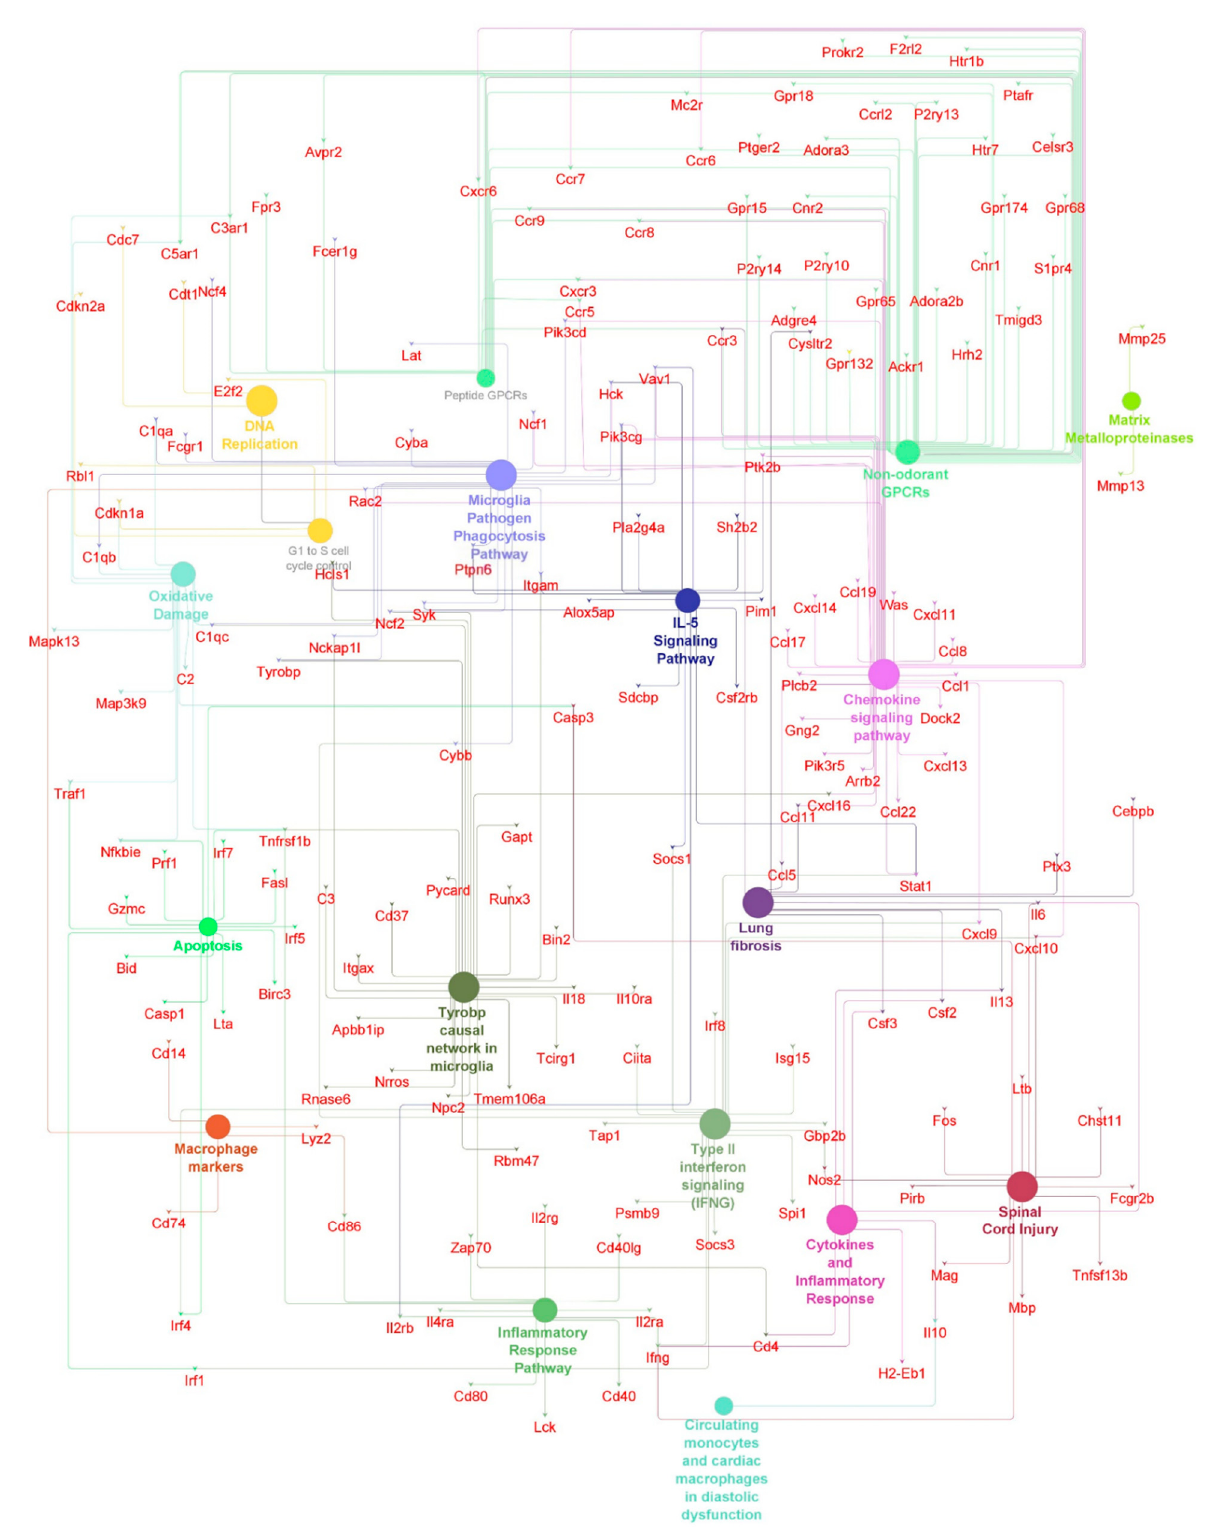
Figure 5. Antiarrhythmic pathways and associated genes in TRI-group. High expressed genes (small dots) and pathways (big dots) including macrophage markers, IL-5 signaling pathways, inflammatory and anti-inflammatory pathways ( q ≤ 0.05). Node size-number of genes. Edges-relation based on kappa score 0.6 using experimental data.